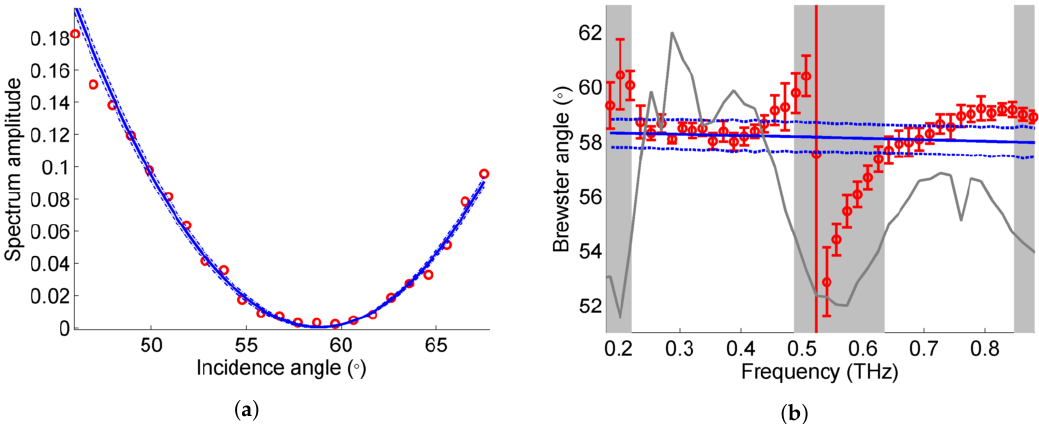
Figure 4. ( a ) Example of a fit on I p for ν = 0.27 THz. ( b ) Brewster angle as a function of the frequency, compared with the results of the spectroscopy in transmission (blue lines); the spectrum (gray line) is shown for reference, the frequency ranges with low signal are